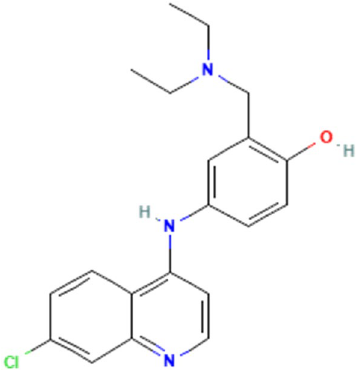
Figure 1. Chemical structure of the amodiaquine compound.